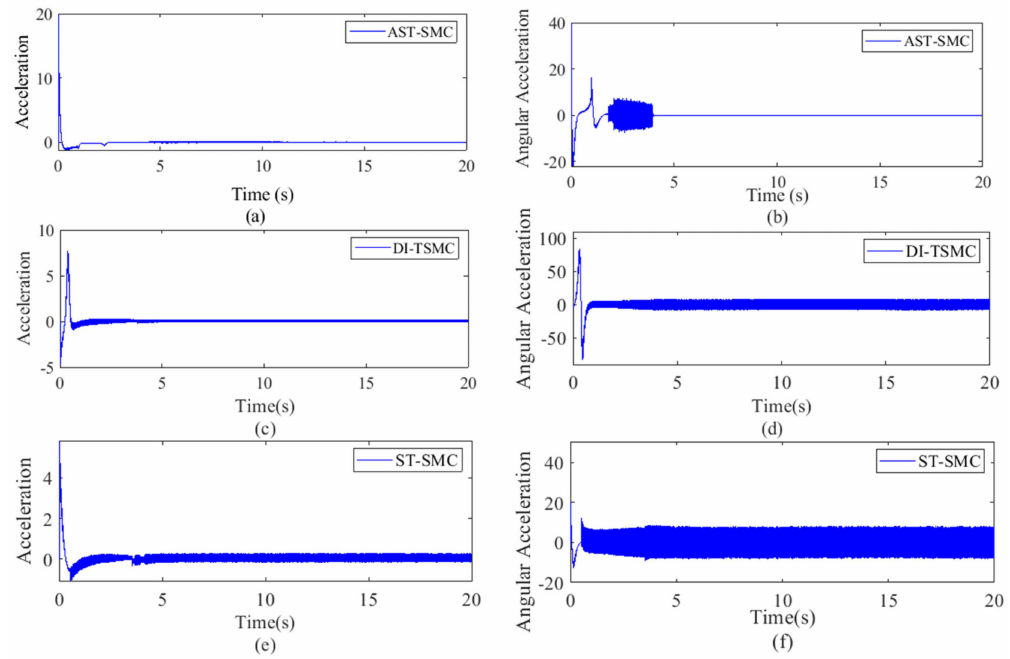
Figure 5. Comparisons of the control inputs from the follower 2. ( a ) Acceleration by AST-SMC, ( b ) angular acceleration by AST-SMC, ( c ) acceleration by DI-TSMC, ( d ) angular acceleration by DI-TSMC, ( e ) acceleration by ST-SMC, ( f ) angular acceleration by ST-SMC.